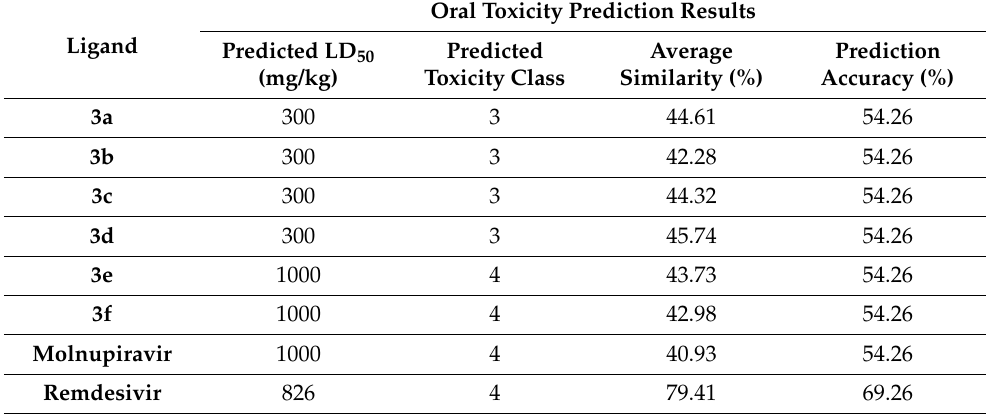
Table 3. Acute oral toxicity predicted by the ProTox-II web server for ligands 3a–f and the ap- proved